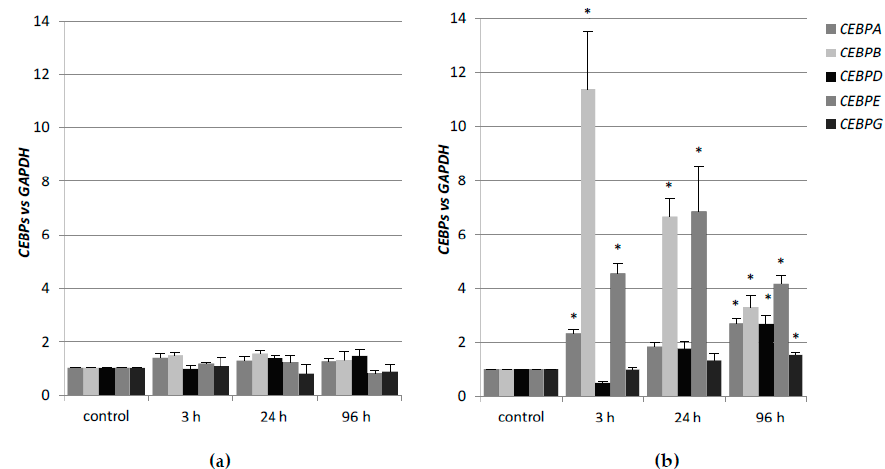
Figure 2. Regulation of CEBP genes in KG1 exposed to 1,25D ( a ) or to ATRA ( b ). KG1 cells were exposed to 10 nM 1,25D or 1 μ M ATRA and after desired time the expression of CEBP genes was measured by Real-time PCR. The bars represent mean values of the fold changes (±SEM) in mRNA levels relative to GAPDH mRNA levels. Expressions in control cells were treated as calibrators. Values significantly different from those that were obtained from respective controls cells are marked with asterisk (* p < 0.05).